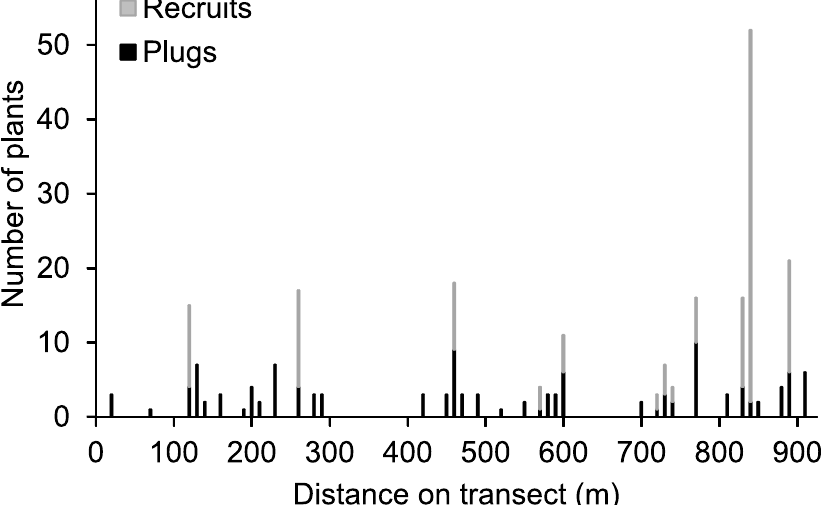
Fig 2. Distribution of golden paintbrush plants along a 920 m transect at Glacial Heritage, five years post-planting. Ten plants were originally planted in groupings at 10 m intervals along the entire transect.